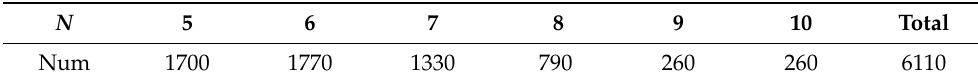
Table 1. The sizes of tapping rhythm